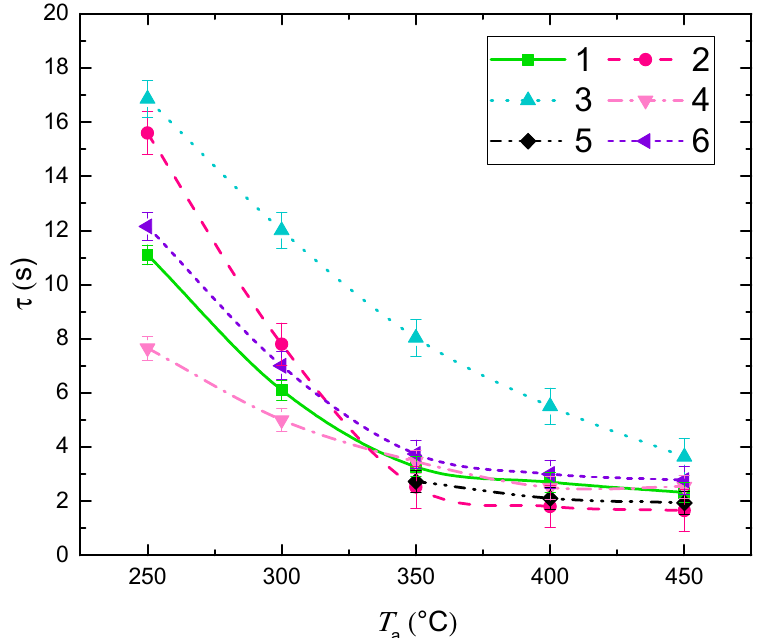
Figure 4. Two-component droplet heating times until explosive breakup vs gas medium temperature with various holders: 1—ceramic; 2—steel; 3—aluminum; 4—steel tube; 5—nichrome; 6—phosphorus. The value T a ≈ 250 °C is the threshold for explosive breakup.